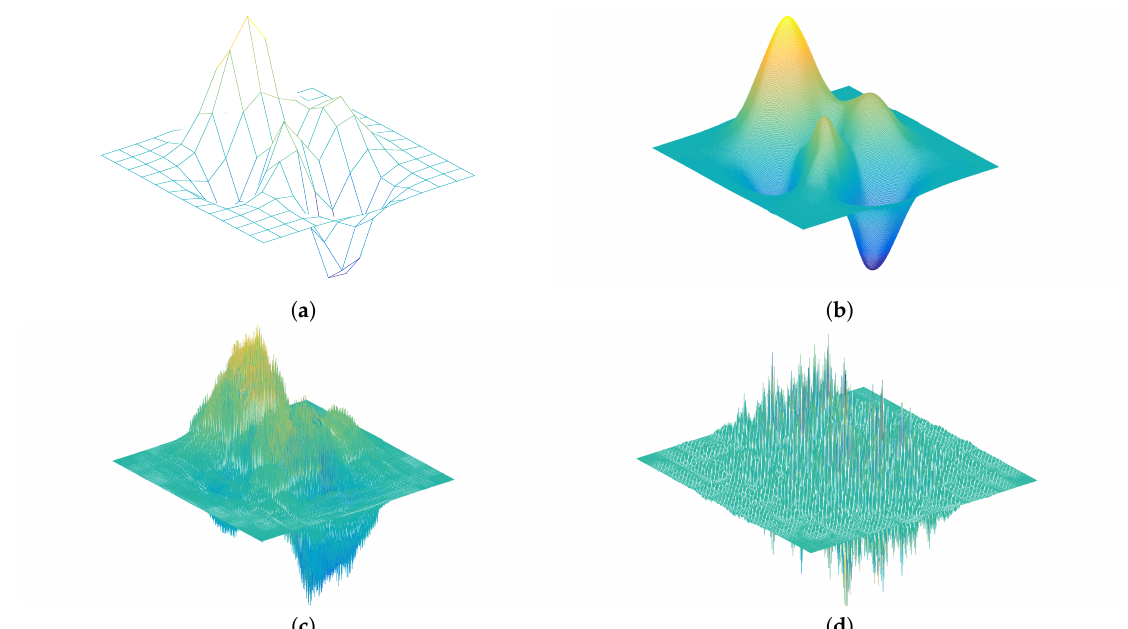
Figure 5. The continuous surface and the fractal surface. The initial control mesh in ( a ) and ( b ) shows the obtained result with α = 3, and the surface is C 1 continuous; ( c ) shows the obtained result with α = 0.008, it is a fractal surface; ( d ) shows the obtained result with α = 0.00795, it is a fractal